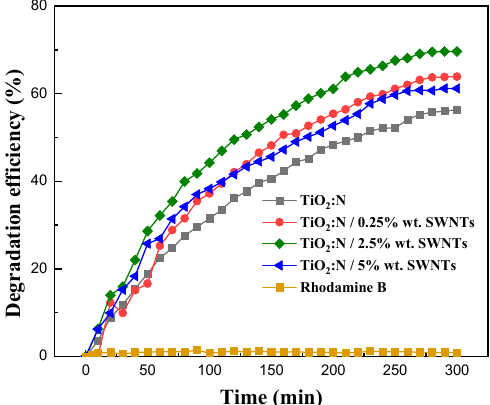
Figure 6. Degradation efficiency of the T and S1–S3 samples dispersed in RhB aqueous solutions after subsequently exposure to UV light.